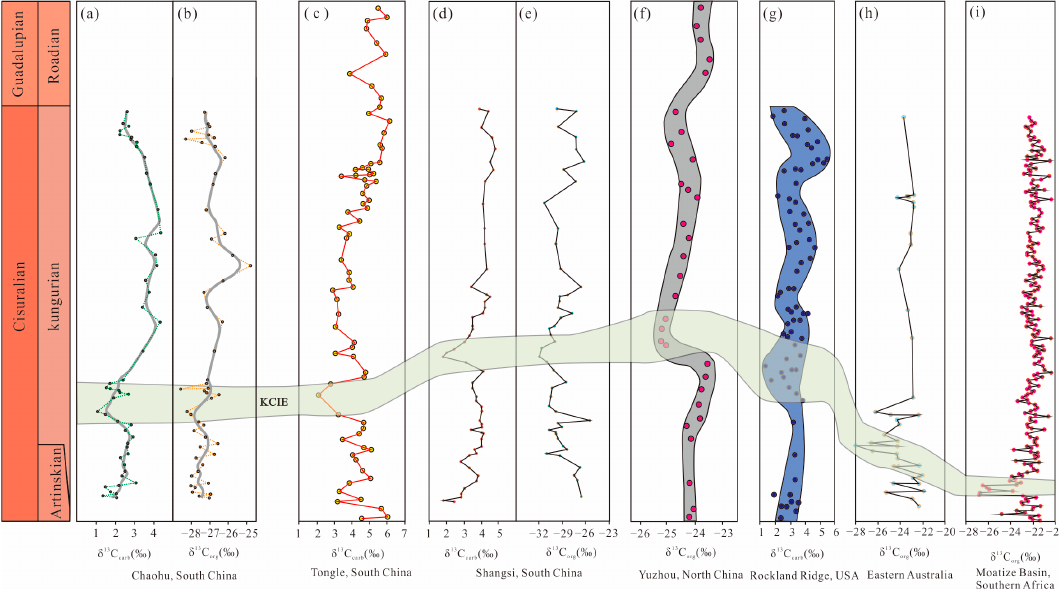
Figure 6. Permian-Kungurian carbon isotope stratigraphic division and correlation. ( a ) δ 13 C carb curve in the study area (marine strata, Lower Yangtze region, South China); ( b ) δ 13 C org curve in the study area (marine strata, Lower Yangtze region, South China); ( c ) δ 13 C carb curve in Tongle section (marine strata, Youjiang Basin, South China; [19]); ( d ) δ 13 C carb curve in Shangsi section (marine strata, Sichuan Basin, South China; [46]); ( e ) δ 13 C org curve in Shangsi section (marine strata, Sichuan Basin, South China; [46]); ( f ) δ 13 C org curve in Yuzhou section (terrestrial strata, North China Platform; [21]); ( g ) δ 13 C carb curve in Rockland Ridge section (marine strata, Nevada, USA; [49]); ( h ) δ 13 C org curve in Eastern Australia section (terrestrial strata, Australia; [47]); ( i ) δ 13 C org curve in Southern Africa section (terrestrial strata, Moatize Basin, Southern Africa; [48]).